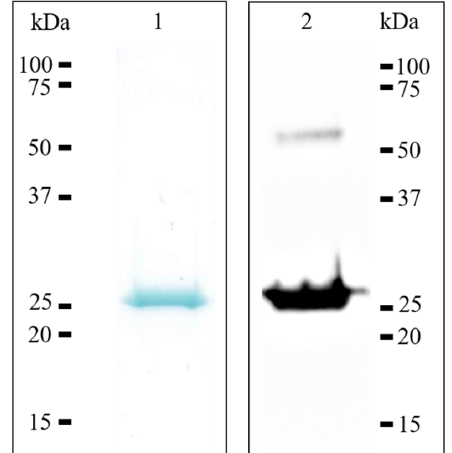
Figure 3. SDS-PAGE and western blotting analysis of recombinant human 17 β -HSD10. Lanes: 1, purified recombinant human 17 β -HSD10 stained by Coomassie Brilliant Blue; 2, purified recombinant 17 β -HSD10 transferred onto PVDF membrane and detected by the monoclonal anti-17 β -HSD10 antibody, showing monomeric and also dimeric form (54 kDa).